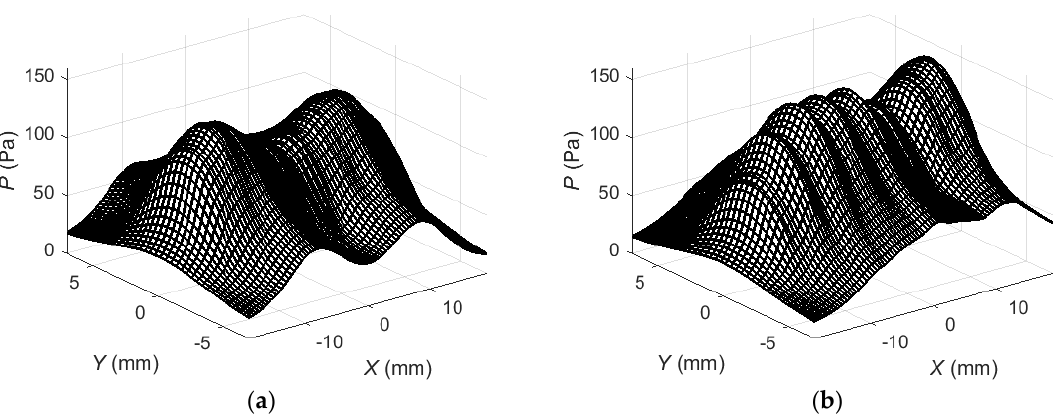
Figure 11. Spatial distribution of acoustic pressure peak values P at the excitation zone of the PVC film: ( a )—simultaneous excitation of all array elements, ( b )—excitation of array elements with delays.